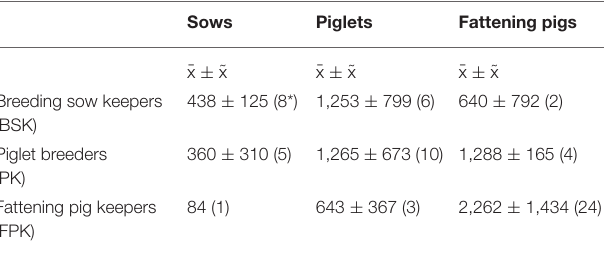
TABLE 1 | Number of kept animals disaggregated by production